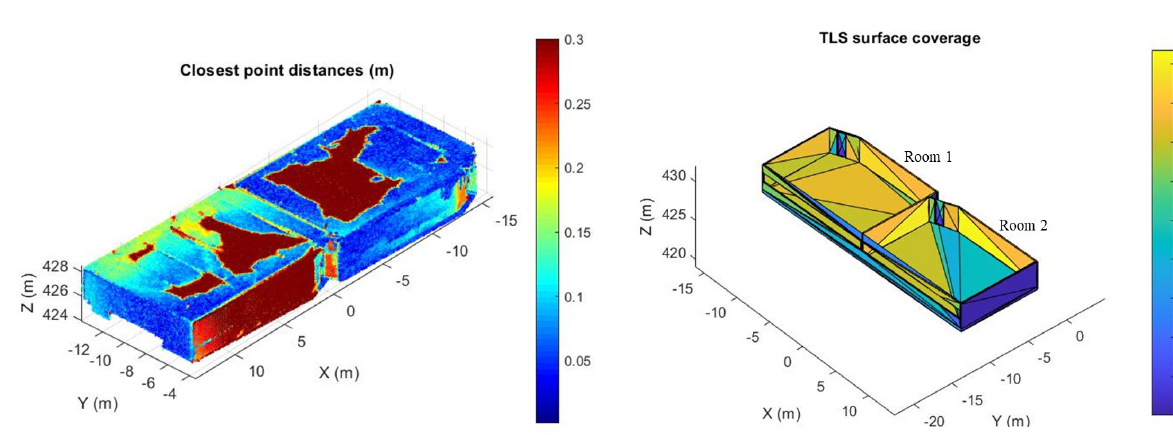
Figure 10 . Coverage of the surfaces by TLS.